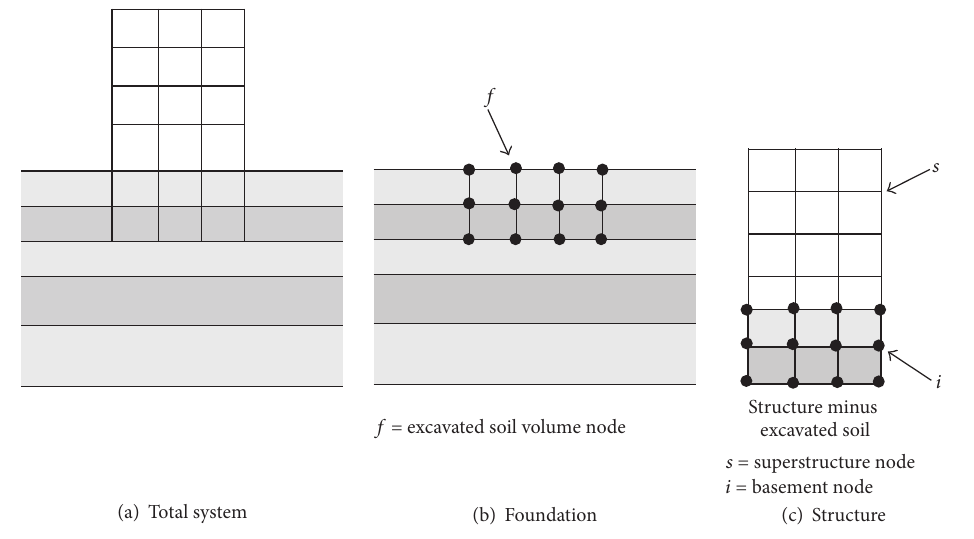
Figure 1: Substructuring in the flexible volume method.